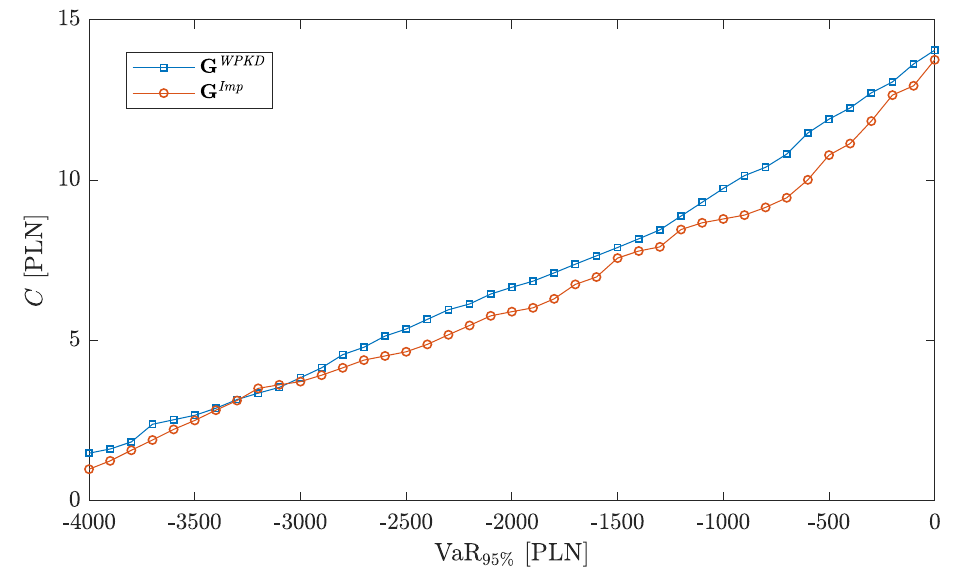
Figure 5. Commission C as a function of the daily VaR 95% . Clearly, the strategy utilizing improved generation forecasts admits lower commission levels than the one using WPKD